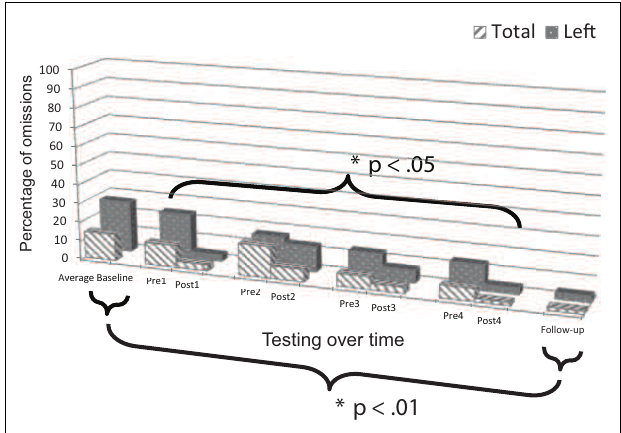
mean baseline performance with performance at follow-up did notshowsignificantimprovementontotaltestresponses, z = 1.41, p =